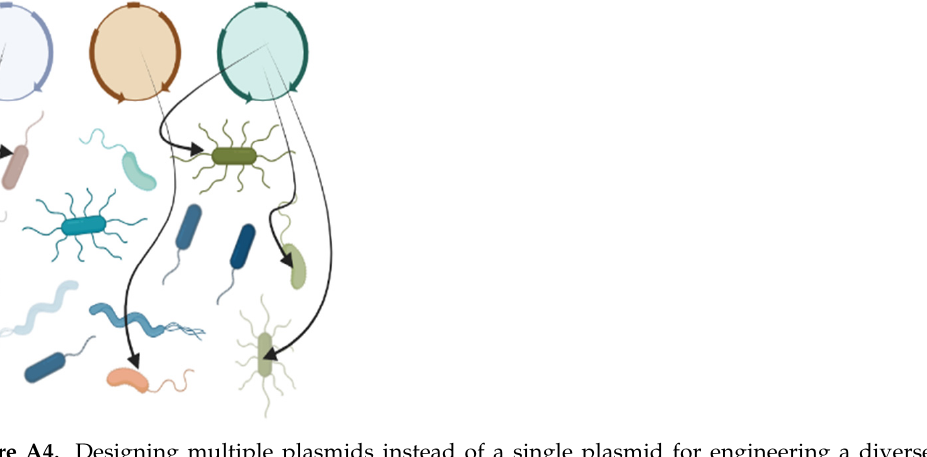
Figure A4. Designing multiple plasmids instead of a single plasmid for engineering a diverse microbiome. Each plasmid targets a different sub-set of the wanted hosts group for which expression should be enhanced, while still designed to have poor expression in unwanted hosts.